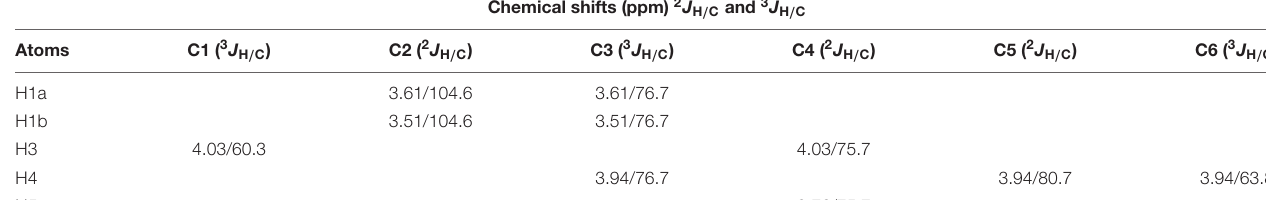
TABLE 3 | HMBC chemical shifts ( δ in ppm) in D 2 O data of the fructosyl residue of levan-type fructan polysaccharides from G. marginata underground storage system. Chemical shifts (ppm) 2 J H / C and 3 J H / C